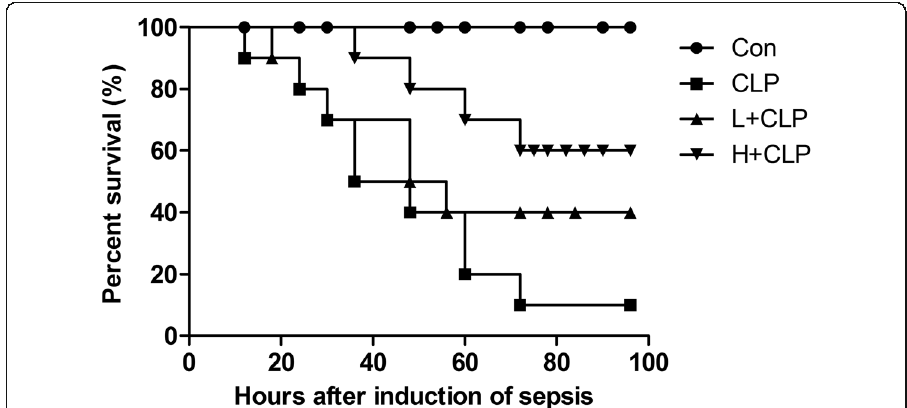
Fig. 1 Survival curves of mice in CLP-induced sepsis with or without honokiol treatment